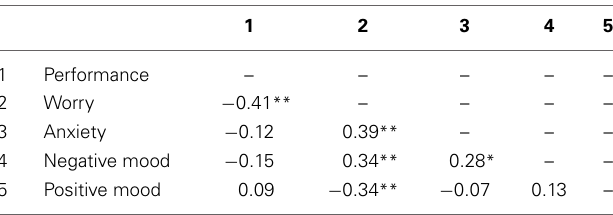
Table 1 | Correlations Between Performance and Individual Differences in Experiment